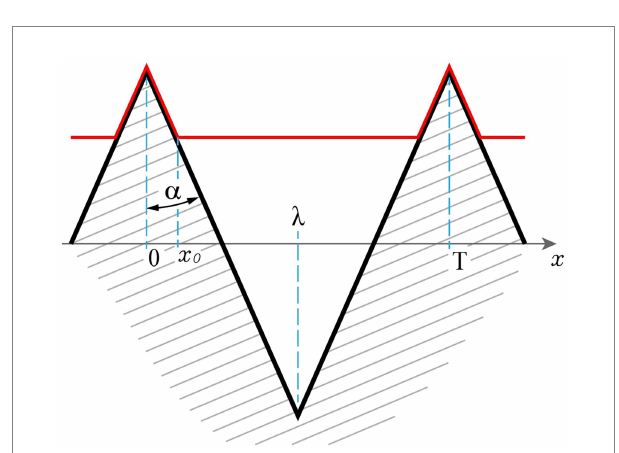
FIGURE 2 Surface geometry and principle of the fiber-surface interaction. The surface (black line) comprises a symmetric triangular shape that is periodic along the x-axis. It is characterized by a distance λ from top to bottom along the x-axis and the half-angle of the triangles α . The fiber (red line) is flexible towards bending and adheres to the surface towards a position x 0 .